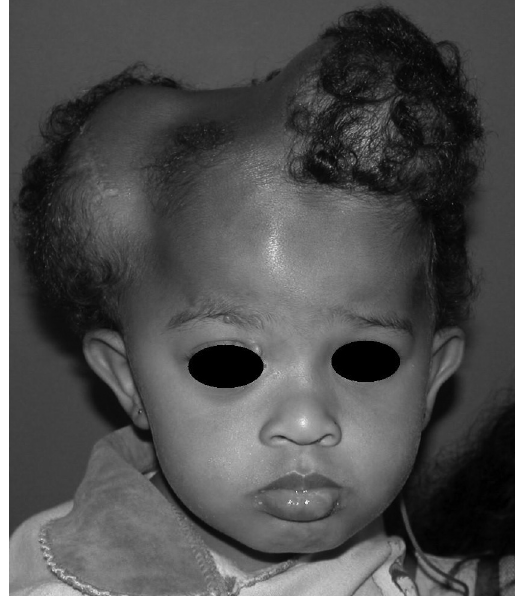
the right hemisphere, subdural collection and parietal calcifications